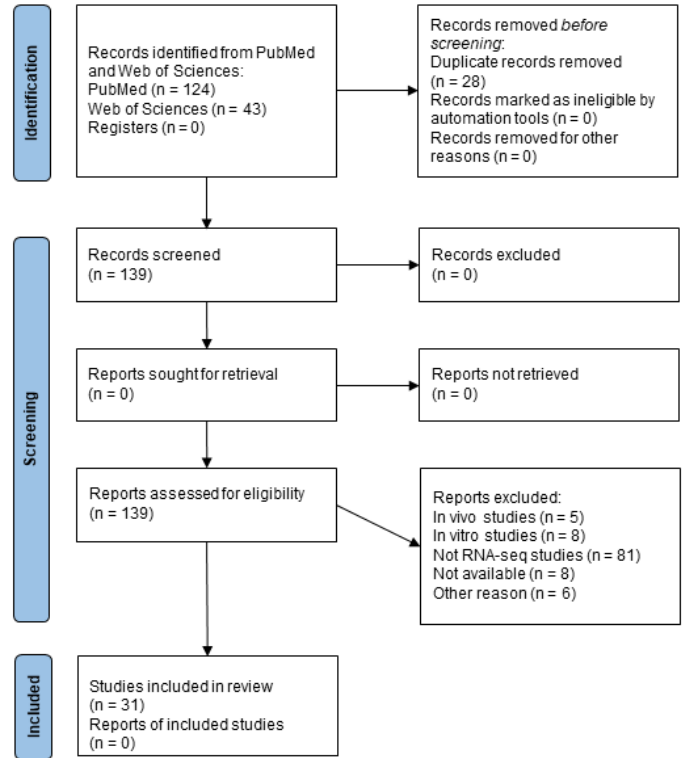
Figure 1. Prisma flow diagram of article selection for bulk studies.